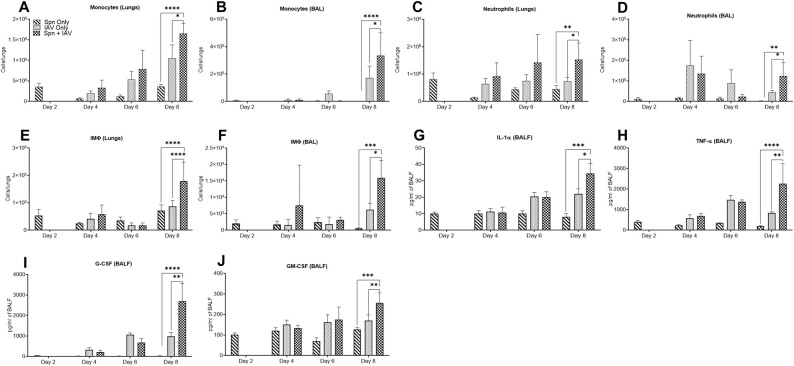
Cell and cytokine profiles in the lungs of pneumococcal-influenza virus superinfected mice.BALB/c mice were infected with Spn on Day 0 and cell subsets in the lungs and BAL were analyzed on Days 2, 4, 6 and 8. In the second group, mice were treated with PBS on Day 0 and infected with IAV on Day 2 and the lungs and BAL were analyzed on Days 4, 6 and 8. The third group was infected with Spn on Day 0 and IAV on Day 2, and then analyzed on Days 4, 6, and 8. Numbers of (A-B) monocytes, (C-D) neutrophils and (E-F) interstitial macrophages were evaluated by flow cytometry. Levels of (G) IL-1α, (H) TNF-α, (I) G-CSF, and (J) GM-CSF were evaluated in BALF by Luminex assay. Data are presented as mean ± SD from 4 mice/group. Statistical analyses were performed by two-way ANOVA. *P<0.05; **P<0.01; ***P<0.001; ****P<0.0001.